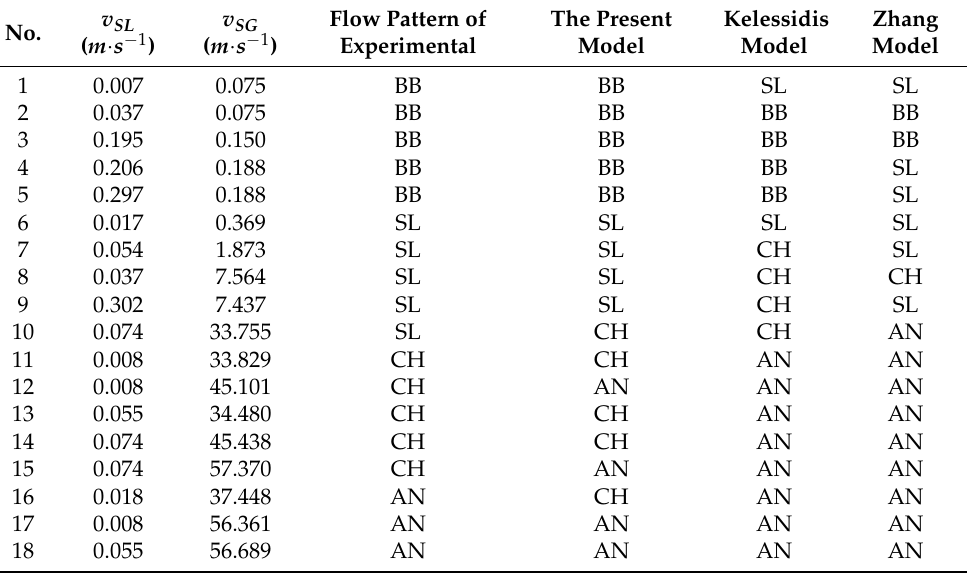
Table 5. Comparison of model predictions with experimental results at an inclination angle of 30 ◦ .